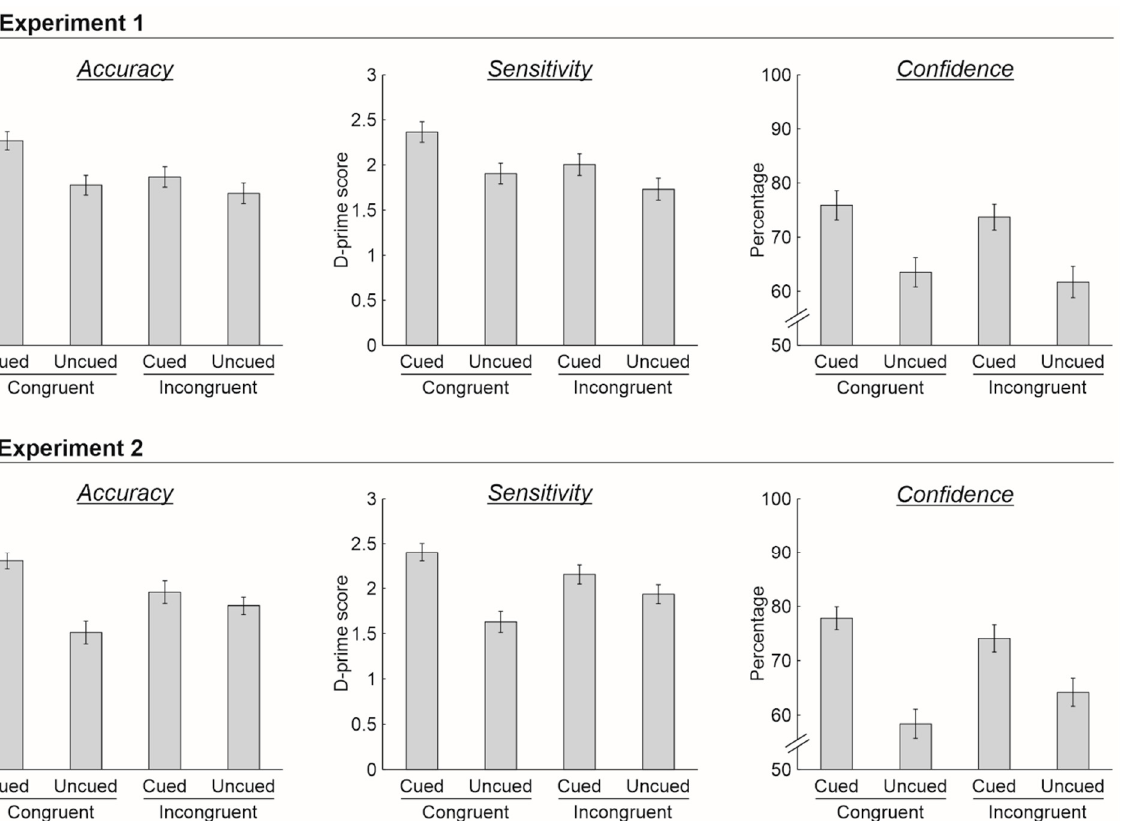
Figure 2. Participants’ performance in Experiment 1 ( A ) and Experiment 2 ( B ) in terms of mean accuracy, sensitivity, and response confidence as a function of crossmodal semantic cuing (cued vs. uncued targets) and target contextual congruence (congruent vs. incongruent targets). In each graph, the error bars represent the standard error of the mean.